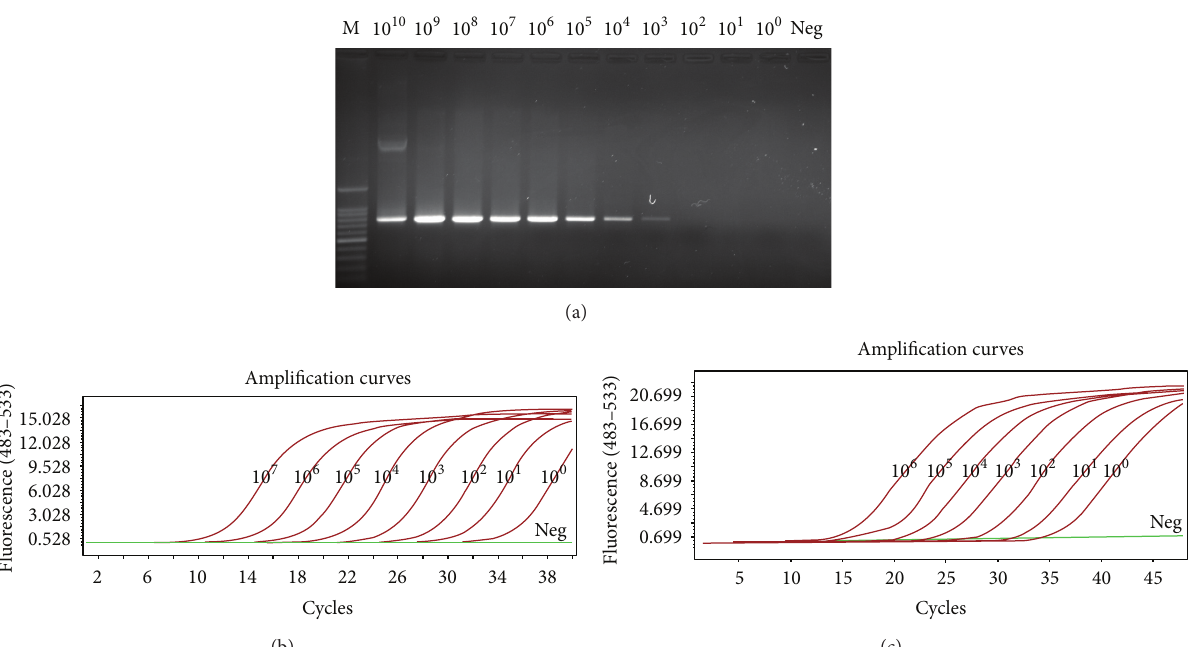
Figure 5: Comparison of sensitivity for HP-PRRSV detection by conventional RT-PCR and real-time PCR. Samples were 10-fold serially diluted plasmid standards of HP-PRRSV. M: 100 bp marker; Neg: negative control.